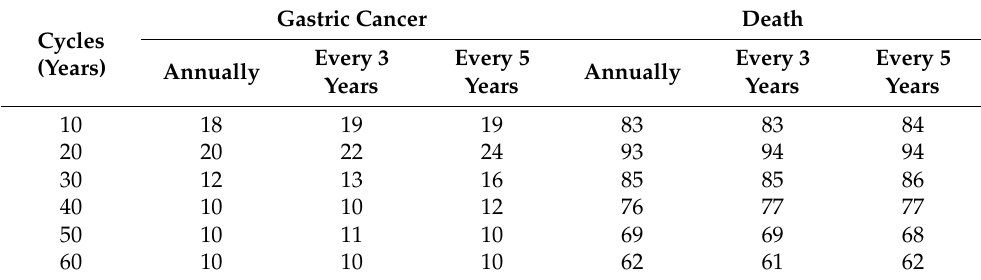
Table 2. Distribution of gastric cancer and death states (each group had 10,000 persons).